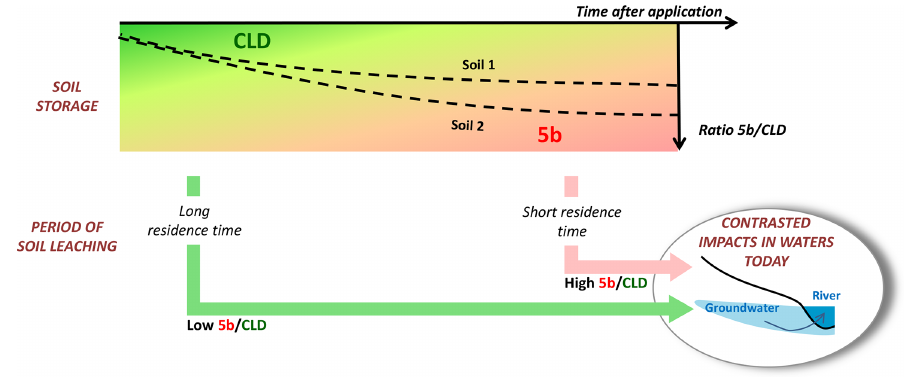
Figure 9. CLD fate in soils and residence time combined to explain 5bCLD / CLD ratio levels in SW. For SW draining GW with a long residence time, leaching occurred during the application period with a low 5bCLD / CLD ratio whatever the soil type. For SW water draining GW with a short residence time, leaching occurs nowadays from soil with a higher 5bCLD / CLD ratio depending on soils and reflecting CLD fate in